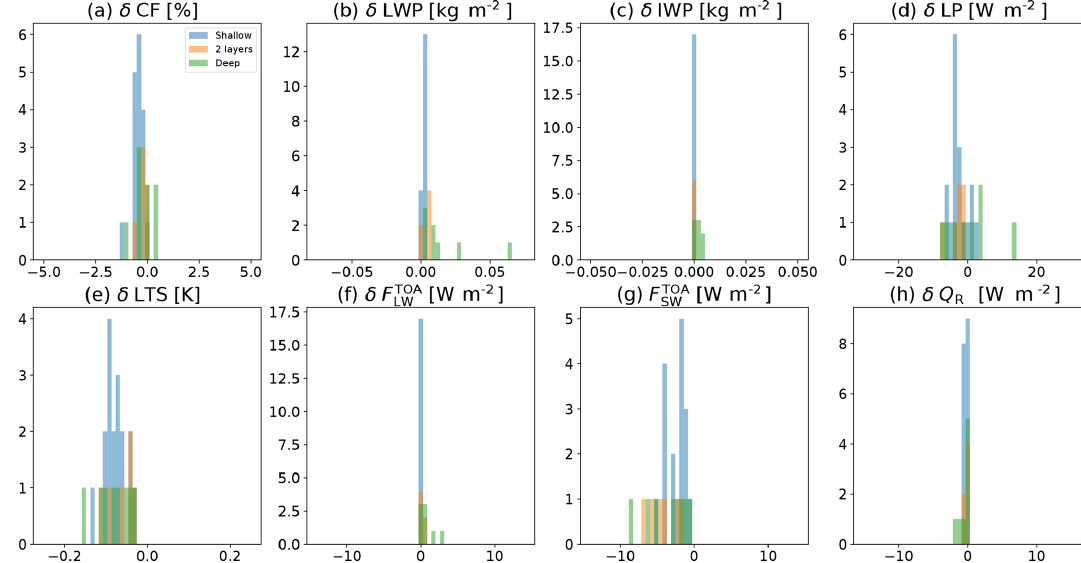
Figure 8. Histograms of the domain and time mean response of cloud and atmospheric properties to the CDNC perturbation (polluted simulations minus clean simulations) for each day of the NARVAL 1 month (December 2013) separated into the different cloud regimes: shallow clouds (blue), two-layer clouds (shallow clouds with cirrus clouds layer above – orange), and deep clouds (green). (a) Cloud fraction